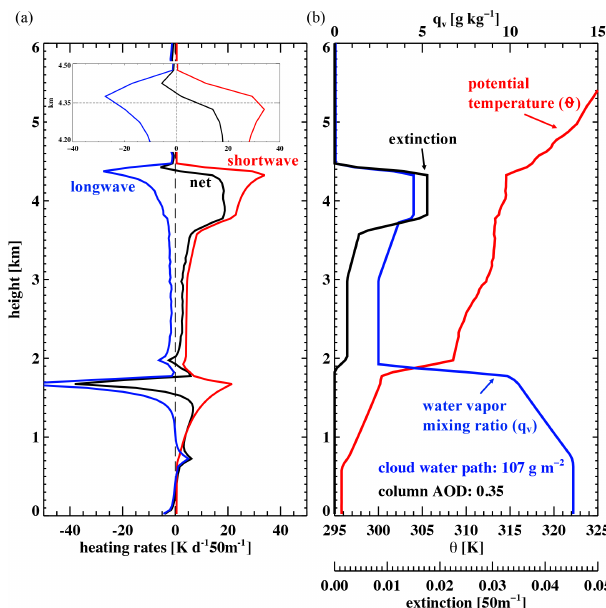
Figure 10. (a) Calculated instantaneous shortwave (red), longwave (blue), and net (black) heating rate profiles at noon on 2 Septem- ber 2017. The insert magnifies to the 4.2–4.5km range, centered on the layer top. (b) θ (red) and q v (blue) profiles from the noon sounding, and the MBL-derived extinction profile (black; following Delgadillo et al., 2018). The corresponding column-integrated AOD and cloud water path are